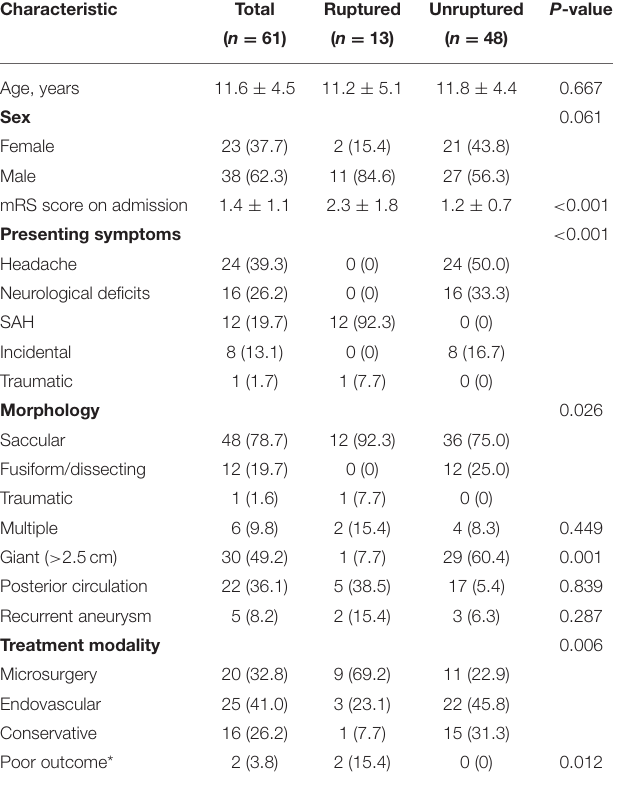
TABLE 1 | Characteristics of patients.